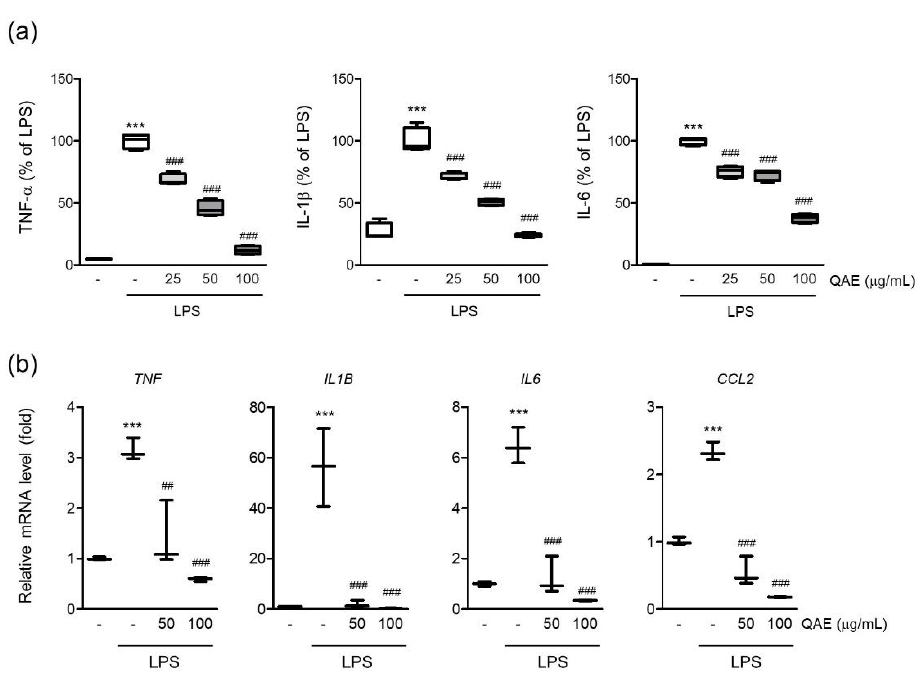
Figure 3. QAE inhibits proinflammatory cytokine expression in LPS-stimulated BV2 microglial cells. BV2 microglial cells were preincubated with QAE (25–100 µ g/mL) for 3 h, and subsequently exposed to LPS (100 ng/mL) for ( a ) 12 h or ( b ) 8 h. ( a ) Level of proinflammatory cytokine production. The production of tumor necrosis factor- α (TNF- α ), interleukin (IL)-1 β , and IL-6 in conditioned media was determined by enzyme-linked immunosorbent assay ( n = 4). ( b ) mRNA expression of proinflammatory cytokines. Relative mRNA expression of TNF- α ( TNF ), IL-1 β ( IL1B ), IL-6 ( IL6 ), and monocyte chemoattracted protein-1 (MCP-1) ( CCL2 ) was measured by RT-qPCR, and normalized by GAPDH expression of each sample ( n = 3). Significant versus control, *** p < 0.001; Significant versus LPS alone-treated group, ## p < 0.01, ### p < 0.001.